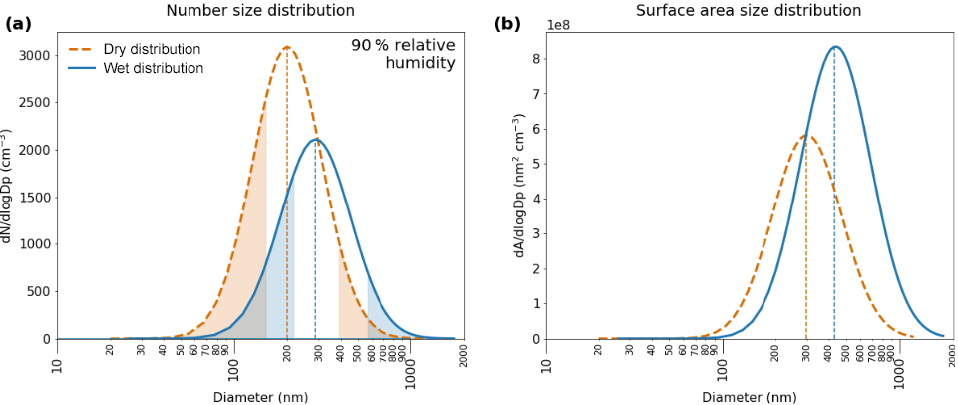
Figure 8. The dry and wet idealised (a) number and (b) volume size distributions based on an aerosol mass of 10µgm − 3 and an RH of 90%.